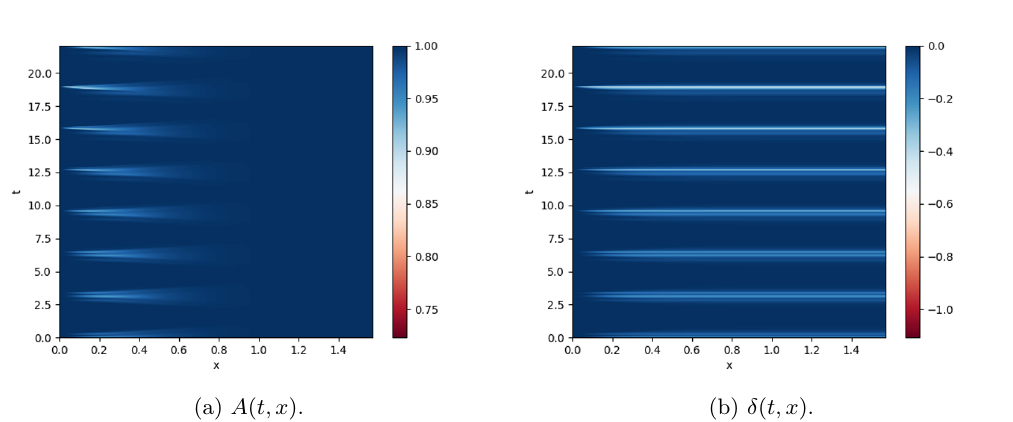
Figure 1. Metric functions for collapse of a massless scalar in AdS 5 with initial width σ = 0 . 25 and amplitude a = 3 . 87